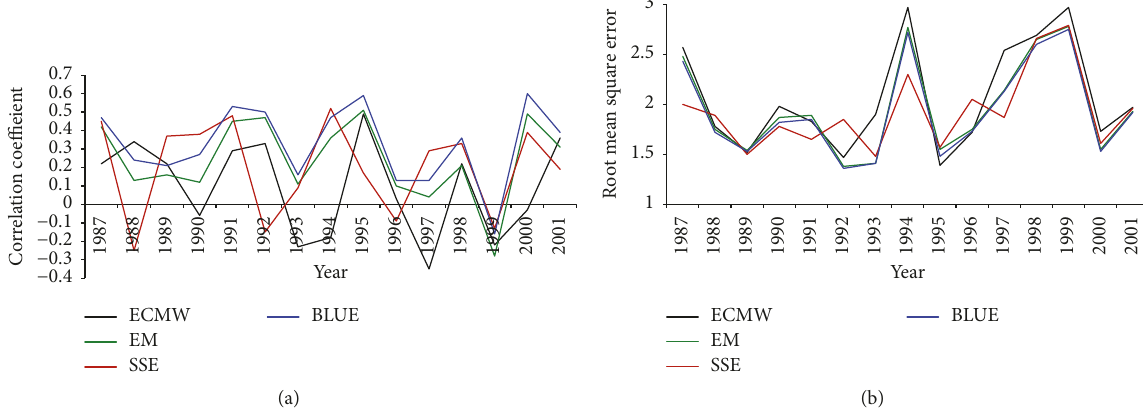
Figure 2: (a) CC and (b) RMSE for ECMWF, EM, superensemble scheme, and BLUE for JJAS seasonal rainfall anomaly predictions. Area averaged over Indian region (69–92E,